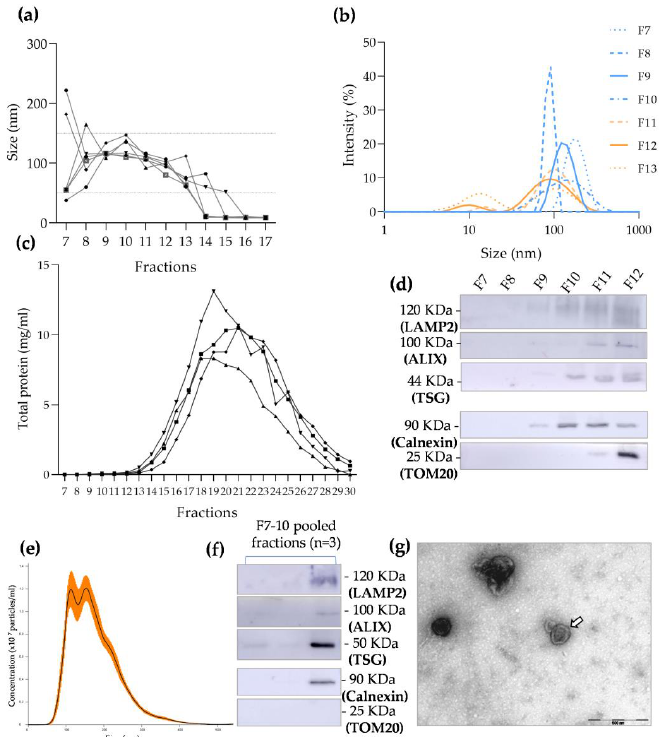
Figure 3. Characterization of total fractions and extracellular vesicle (EV)-enriched fractions obtained using size-exclusion chromatography (SEC): ( a ) dynamic light scattering (DLS) analysis of particle sizes in fractions 7 to 17, where the ranging size of small EVs (50 – 150 nm) is highlighted by the dotted line and values correspond to the highest-intensity population in each fraction; ( b ) DLS analysis of particle size distribution in fractions 7 to 13, where the orange lines represent fractions containing two differently sized peaks of intensity and the blue lines correspond to a one-intensity-peak EV population ( n = 1); ( c ) graph demonstrating total protein quantification in fractions 7 to 30 ( n = 4); ( d ) Western blot membrane showing the expression of specific EV positive markers, such as LAMP2 (fractions 9 to 12), ALIX (fractions 10 to 12), and TSG101 (fractions 9 to 12), and the presence of calnexin and TOM20 contamination in fractions 9 to 12 and fractions 11 to 12, respectively (see Supplementary materials for controls); ( e ) nanoparticle tracking analysis (NTA) of particle concen- tration and size distribution in EV-enriched fractions (F7 – 10), where the orange bars indicate ± SEM; ( f ) Western blot membrane showing the expression of specific EV positive markers (LAMP2, ALIX, and TSG101) and calnexin contamination in EV-enriched fractions, but no detectable presence of TOM20 (see Supplementary materials for controls); ( g ) representative transmission electron micros- copy image of the EV-enriched fractions isolated using SEC (EV cup-like structure indicated by the arrow).